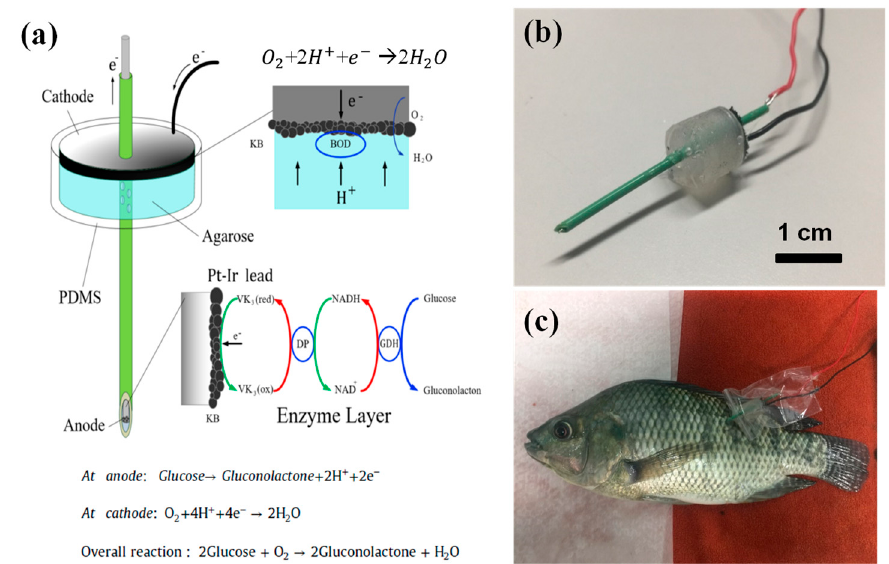
Figure 2. ( a ) Schematic structure of the N-EFC and schemes of glucose oxidation at the anode along with O 2 reduction at the enzymatic gas-diffusion cathode. ( b ) and ( c ) Images of the N-EFC and the N- EFC inserted into a living fish (Tilapia) around the caudal area to access biofuels and a